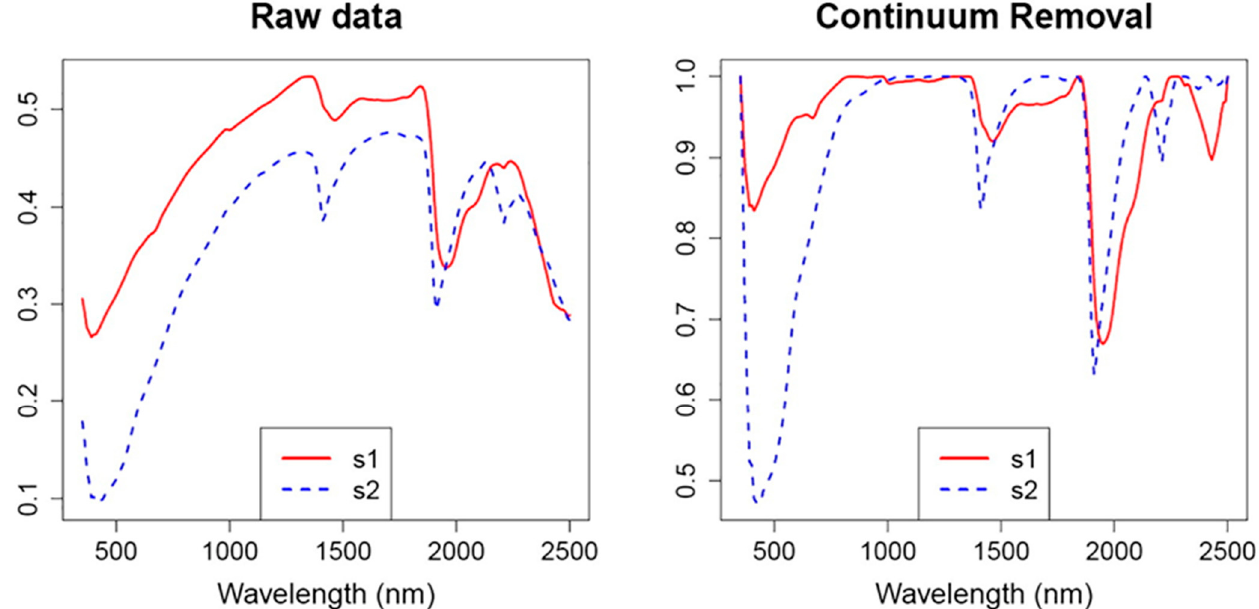
Figure 3. Plots of the typical reflectance spectra and continuum-removed spectra of the two different types of soils with the lowest (S1) and highest (S2) total As contents (adapted from Chakraborty et al., 2017 [95]).